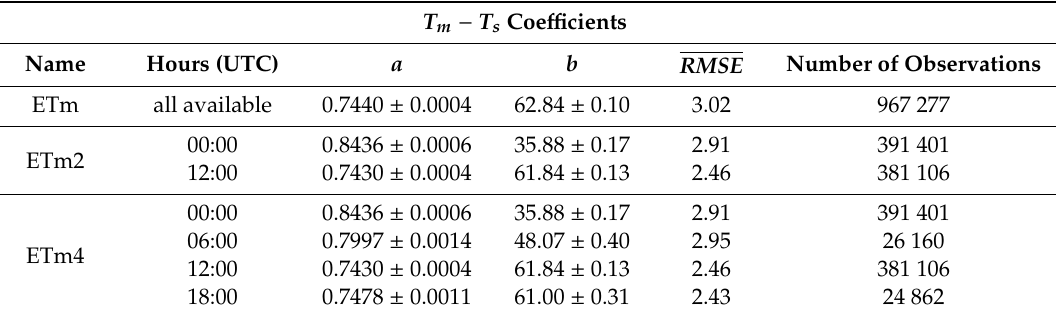
Table 2. Summary of the estimated T m − T s coe ffi